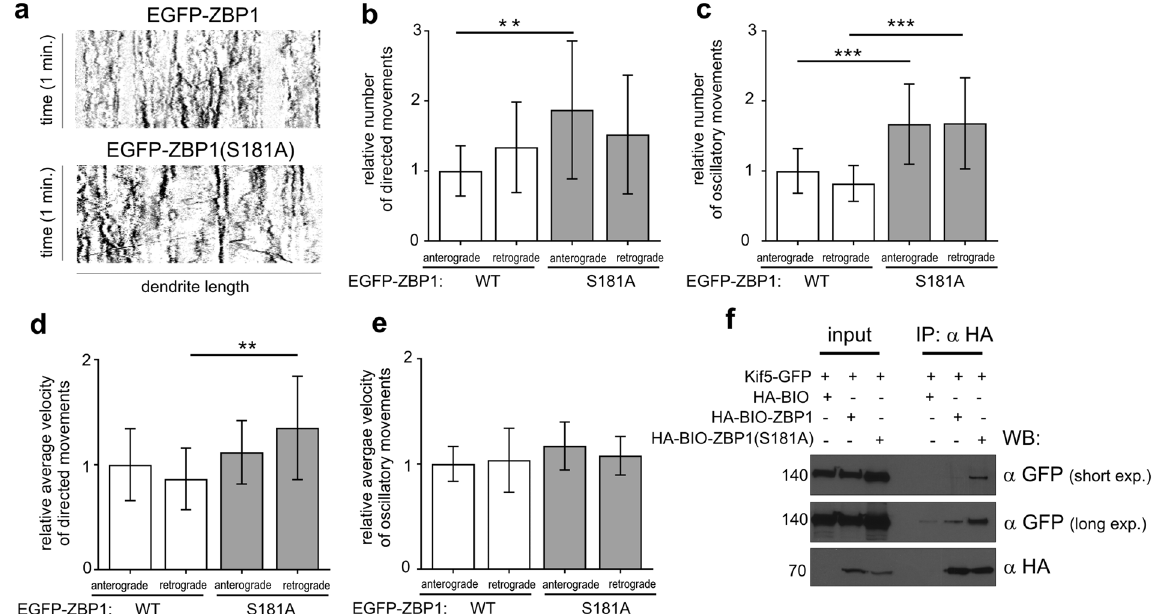
Figure 5. Non-phosphorylated ZBP1 granules are more motile. ( a ) Representative kymographs showing motility of EGFP-ZBP1 and EGFP-ZBP1 S181A granules in dendrites. ( b , c , d) Relative numbers of ZBP1 and ZBP1 S181A granule movements. Granule movements were quantified, normalized per 10 μ m of the dendrite length, and then normalized to the mean number of anterograde movements in the wildtype ZBP1 variant for each experiment, respectively. The data in the columns are expressed as a ratio to the mean number of movements. ( e) Granule velocity was normalized to the mean anterograde velocity in the wildtype ZBP1 variant for each experiment, respectively. *** p < 0.001, * p < 0.1 (Student’s t -test). The data were